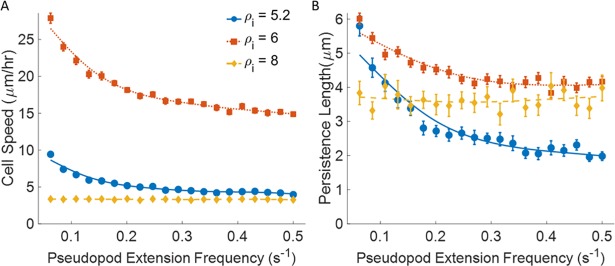
Effect of cell mechanoactivity.Plots for vavg, Lp, μ, and α as a function of increasing cell mechanoactivity A) Cell speed B) Persistence length. Cgel = 3.7 mg/ml, ρfiber = 1.0 x 10−3 fibers/μm3, and AI = 0. Simulation time = 48hrs. n = 20. Dotted red lines are 5.2 motifs/monomer (◼), solid blue lines are 6 motifs/monomer (●), dashed yellow lines are 8 motifs/monomer (◆). Error bars represent ± SEM.